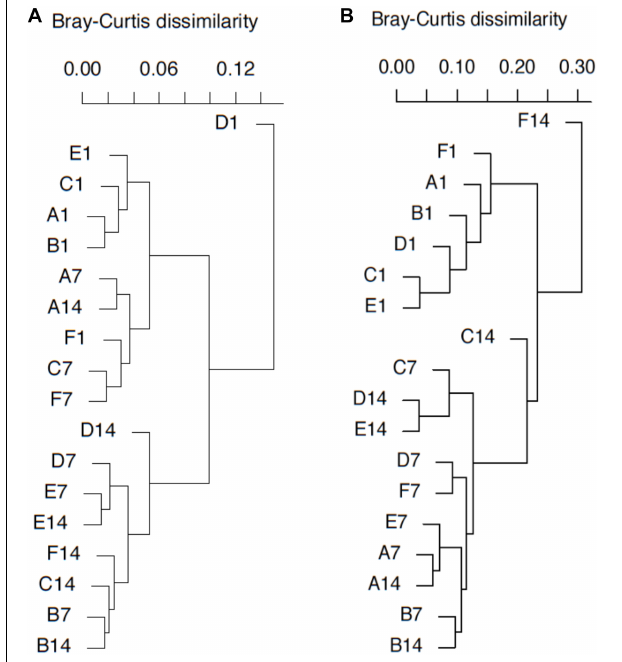
FIGURE 5 | pmoA gene (A) and transcripts (B) -based cluster diagrams of similarity values for samples with different treatments. Dissimilarity levels are indicated above the diagram. For sample name, upper case letters refer to treatment while digits indicate sampling